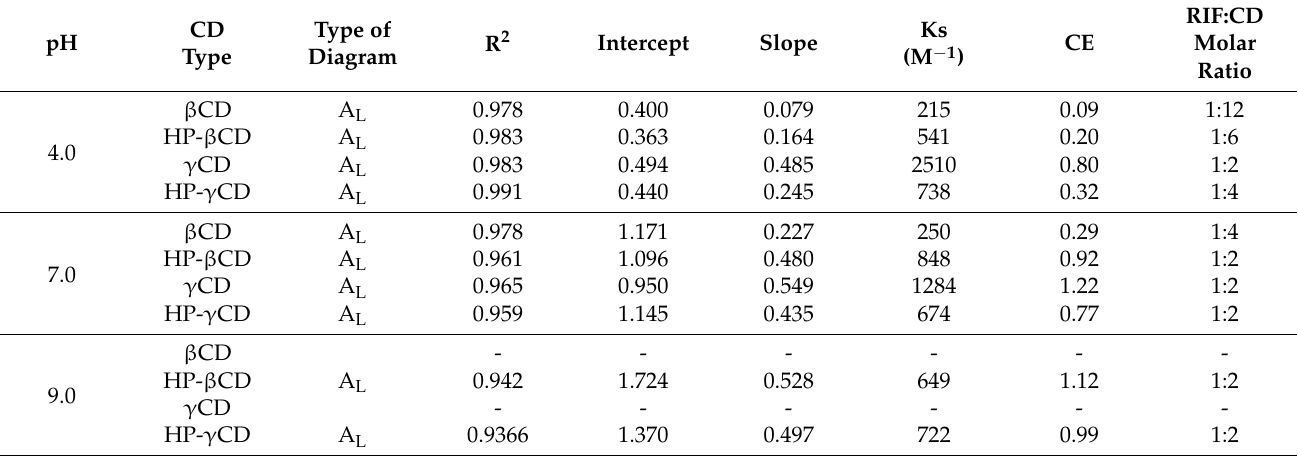
Table 1. Phase solubility data: slope and intercept, binding constant (Ks), complexation efficiency (CE), and rifampicin:cyclodextrin (RIF:CD) molar